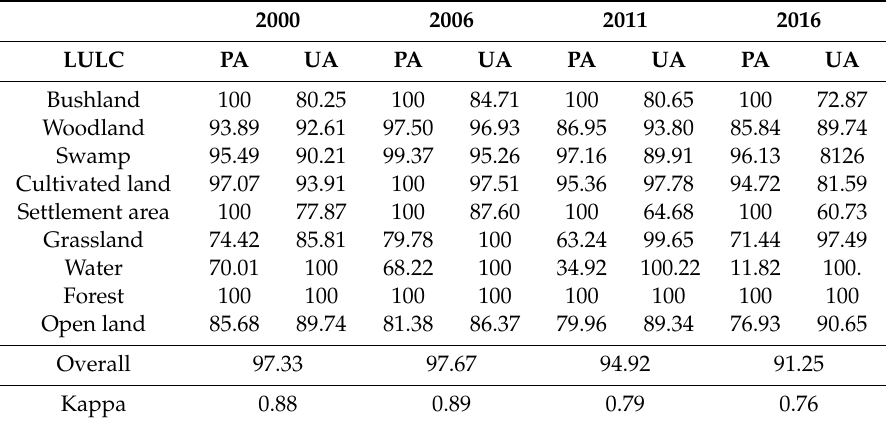
Table 4. Accuracy assessment of the LULC classification at Wami Sub-catchment.